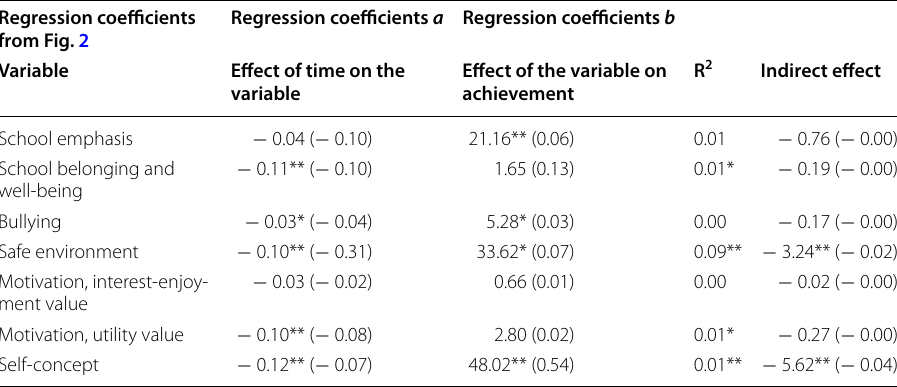
*p < 0,05. **p < 0,001. Standardized regression coefficients in parentheses